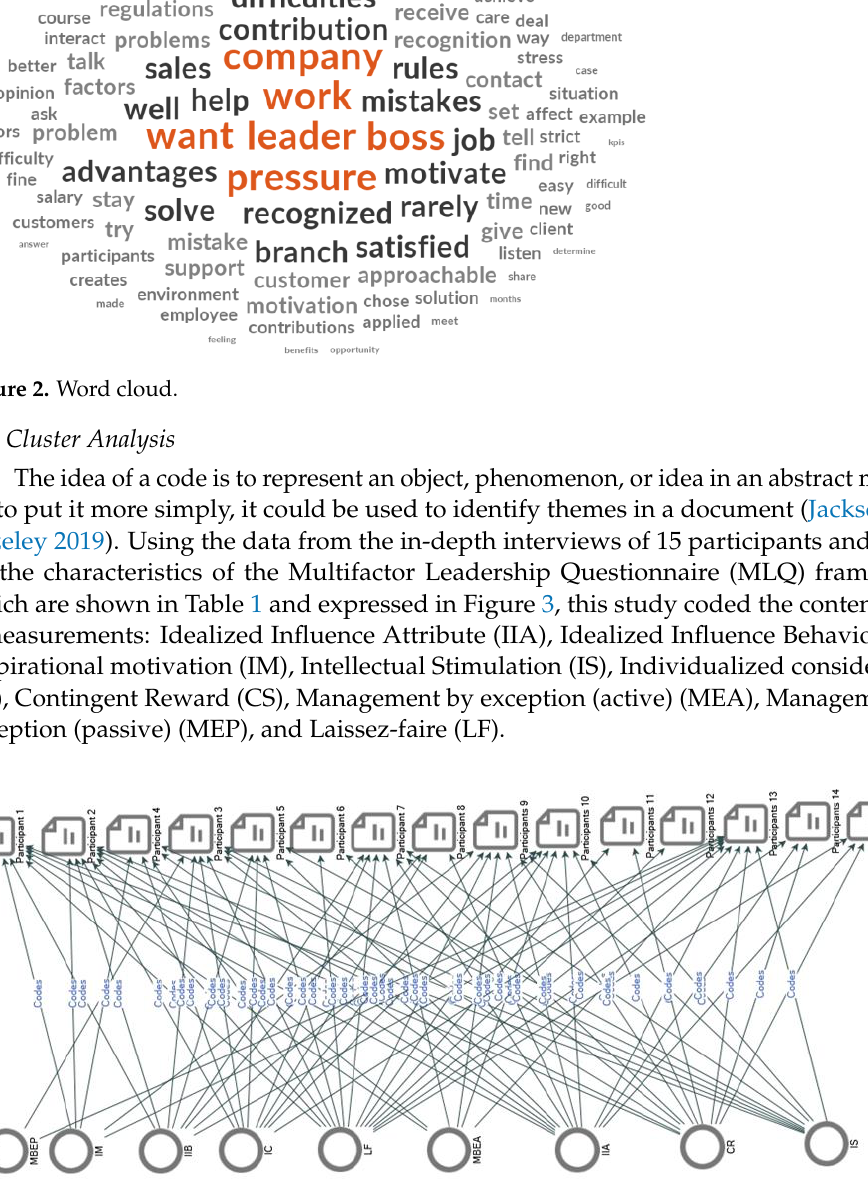
Figure 3. Coding in-depth interviews of 15 participants based on MLQ framework.